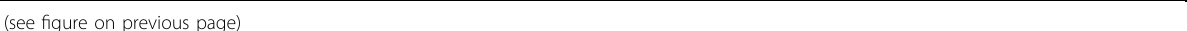
(see fi gure on previous page) Fig. 1 SARS-CoV-2 RNA but not SARS-CoV-2 infection induces SG formation. a Induction of SGs by arsenite, transfection of poly(I:C) and SARS- CoV-2 RNA. HeLa cells were treated with sodium arsenite (1 mM) for 1 h or transfected with poly(I:C) (2 μ g) or SARS-CoV-2 RNA (1 μ g) for 10 h. Cells were immunostained for TIA-1 (green) and G3BP1 (red). Nuclei were stained with DAPI (blue). The cells were observed with a Nikon confocal microscope under a 60× oil objective. b SGs were not induced by SARS-CoV-2 infection. HeLa-ACE2 cells were infected with SARS-CoV-2 (MOI = 1) for indicated times, and then untreated or treated with sodium arsenite (1 mM) for 1 h. Cells were immunostained for TIA-1 (green) and G3BP1 (red). Nuclei were stained with DAPI (blue). The cells were observed with a Nikon confocal microscope under a 60× oil objective. c Transfection of poly(I:C) and SARS-CoV-2 RNA and arsenite treatment induced PKR and eIF2 α phosphorylation. HeLa cells were treated with sodium arsenite (1 mM) for 1 h or transfected with poly(I:C) (3 μ g) or SARS-CoV-2 RNA (2 μ g) for 10 h before immunoblot analysis with the indicated antibodies. d SARS-CoV-2 infection did not induce PKR and eIF2 α phosphorylation. HeLa-ACE2 cells were infected with SARS-CoV-2 (MOI = 1) for indicated times and then untreated or treated with sodium arsenite (1 mM) for 1 h before immunoblot analysis with the indicated antibodies. e – g Formation of SGs induced by RNAs requires PKR and G3BP1. PKR and G3BP1 in HeLa cells were knocked out with the CRISPR/Cas9 system. The knockout ef fi ciencies were detected by immunoblot with the indicated antibodies ( e ). PKR- (gPKR) ( f ), G3BP1- (gG3BP1) ( g ), and control-knockout (gNC) HeLa cells were treated with sodium arsenite (1 mM) for 1 h or transfected with poly(I:C) (2 μ g) or SARS-CoV-2 RNA (1 μ g) for 10 h. The cells were then immunostained for TIA-1 (green) and G3BP1(red) or G3BP2 (red). Nuclei were stained with DAPI (blue). The cells were observed with a Nikon confocal microscope under a 60× oil